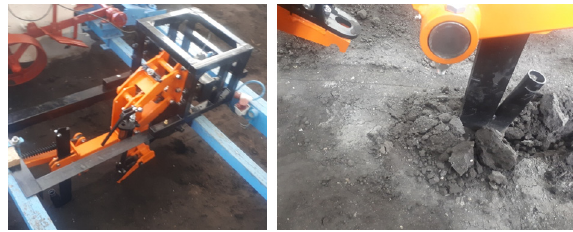
Figure 9. Determining the tractive resistance of the anchor colter of the sowing section